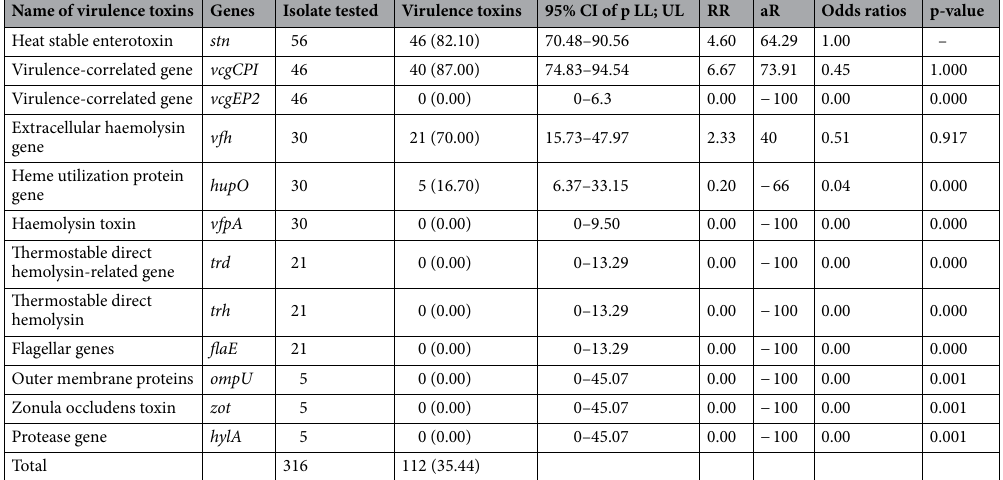
Table 5. Prevalence distribution of virulence toxins of human pathogenic Vibrio spp. by PCR (relative risk and attributable risk), odds ratios in surface waters of each district. CI confidence interval, LL lower limit, UL upper limit, RR relative risk, aR attributed